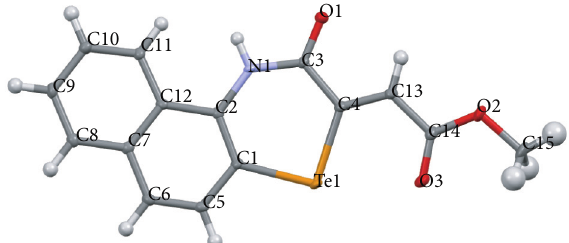
Figure 10: ORTEP plot of methyl (Z)-2-(2-oxo-1,2-dihydro-3(H)- naphtho[2,1-(b)] [1, 4]tellurazin-3-ylidene)acetate 6